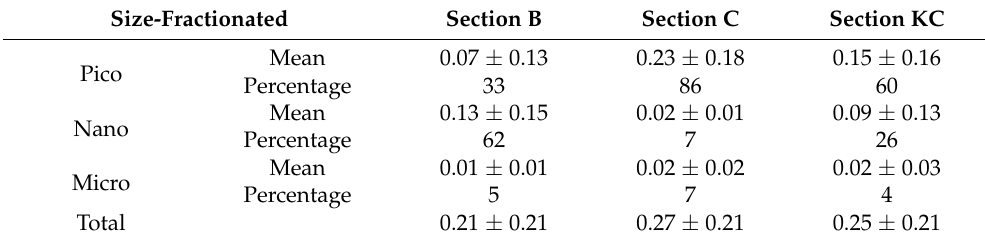
Table 2. Mean ± SD of Chl a ( µ g/L) in three contrasting sections.